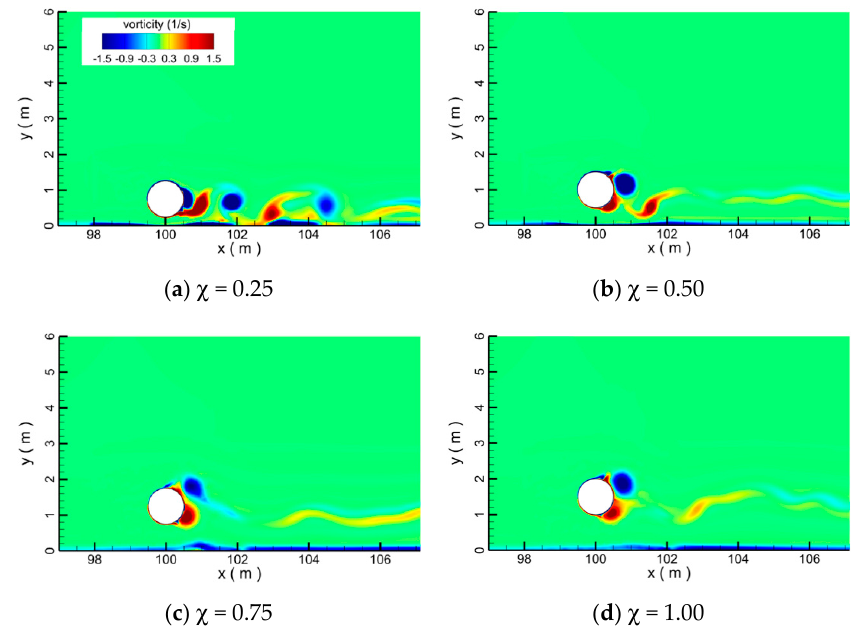
Figure 25. Snapshots of vortices contours for pipelines with different gap-ratios at t=135 s under the tsunami-like wave.